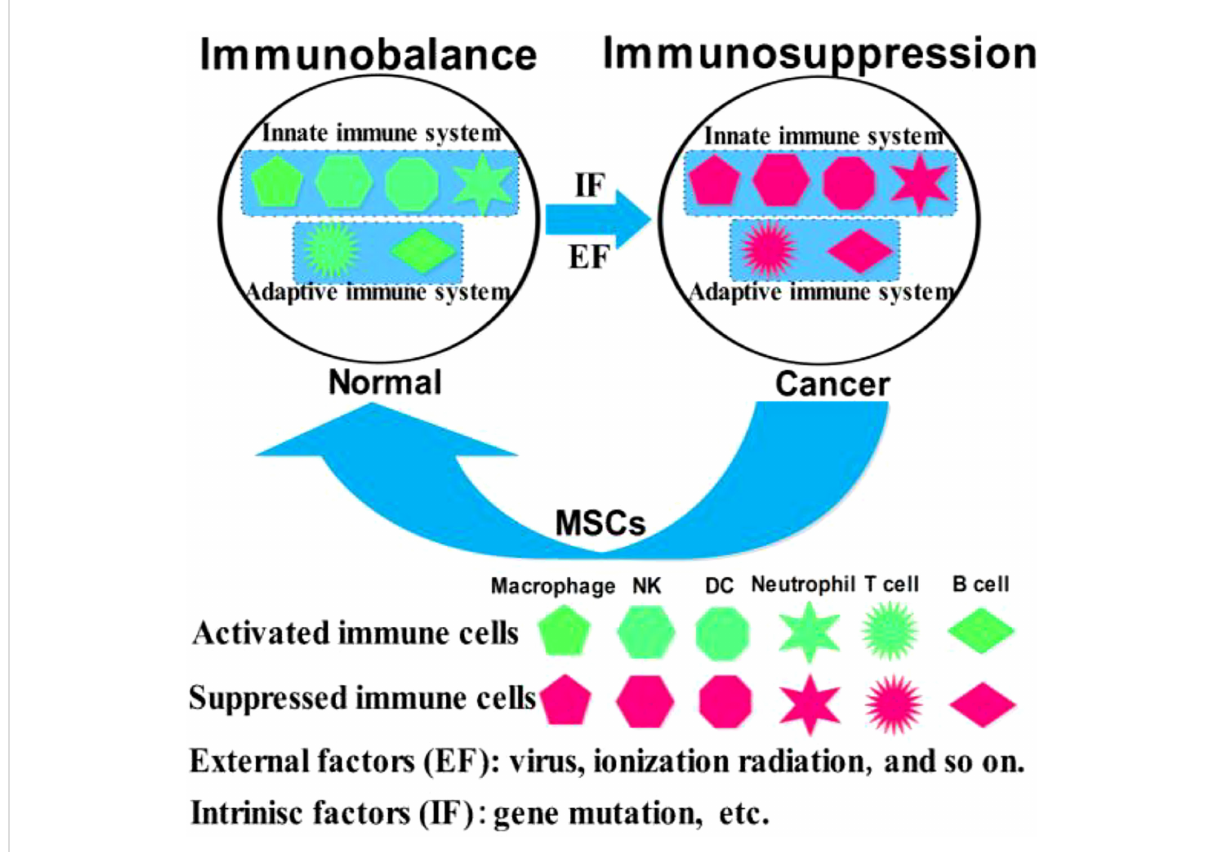
FIGURE 2 Schematic representation of the immunomodulatory roles of MSCs in